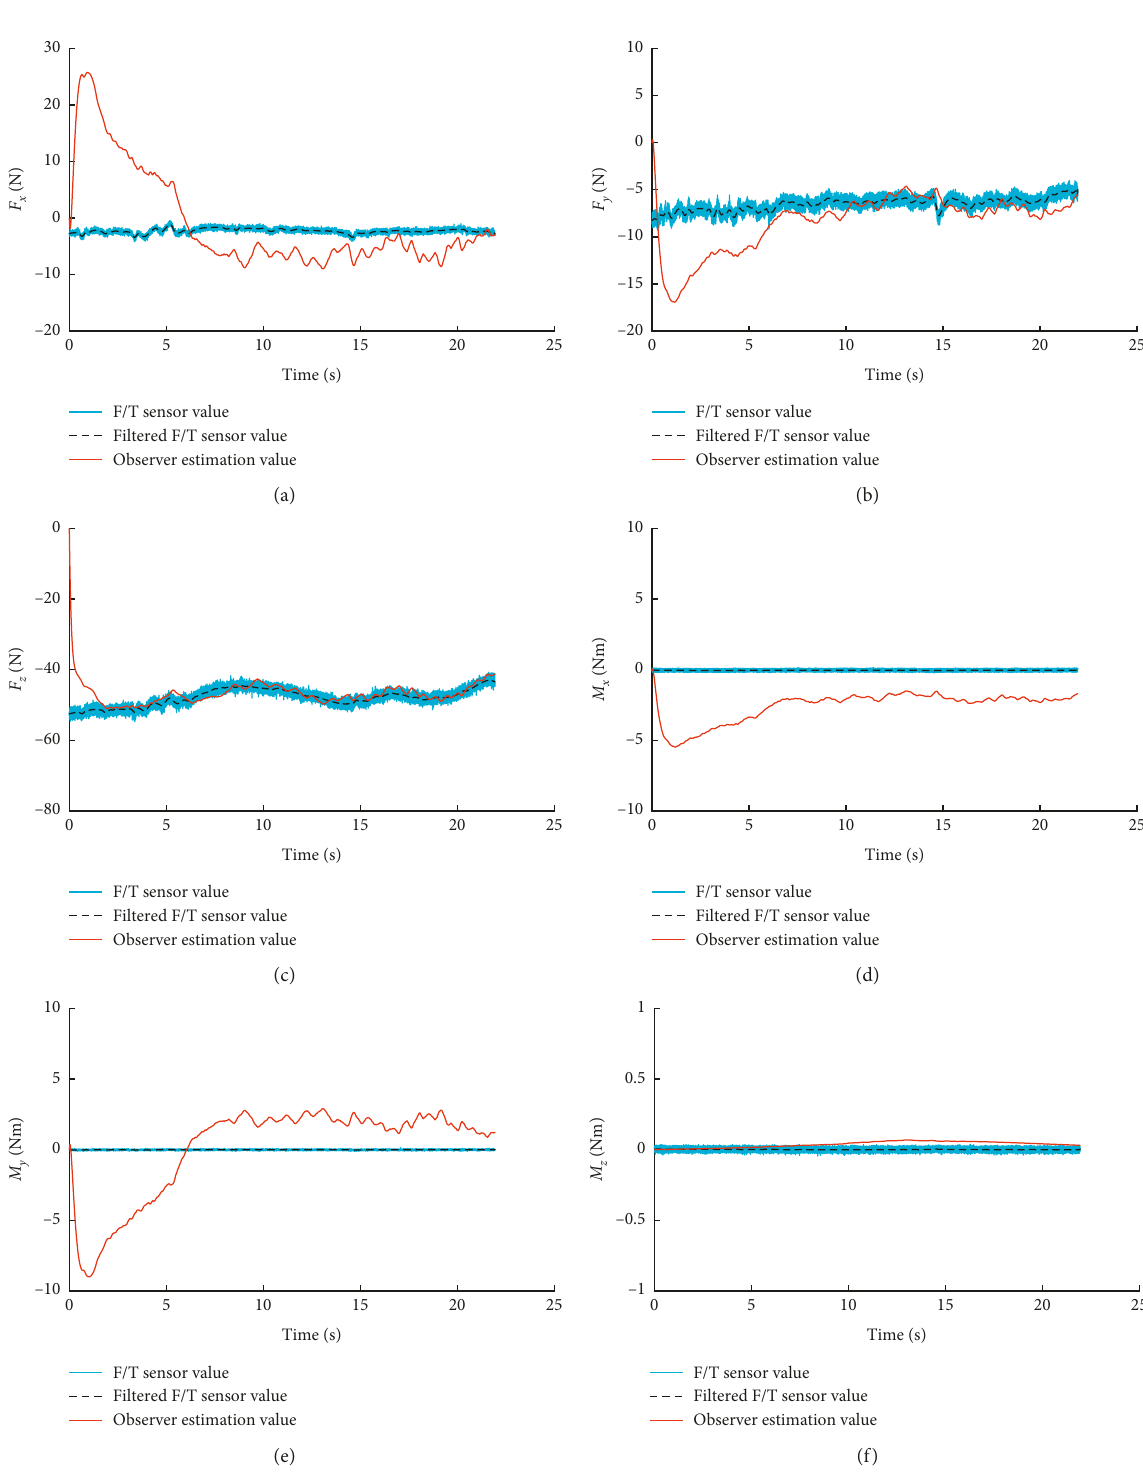
Figure 7: Comparison of disturbance observer estimation values and force/torque sensor values. (a) X -direction force. (b) Y -direction force. (c) Z -direction force. (d) X -direction torque. (e) Y -direction torque. (f) Z -direction